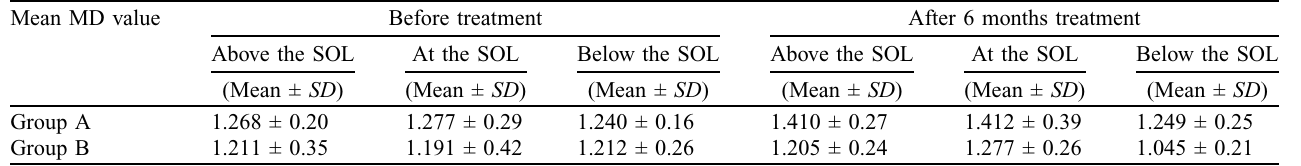
Table 2. Mean MD values in groups A and